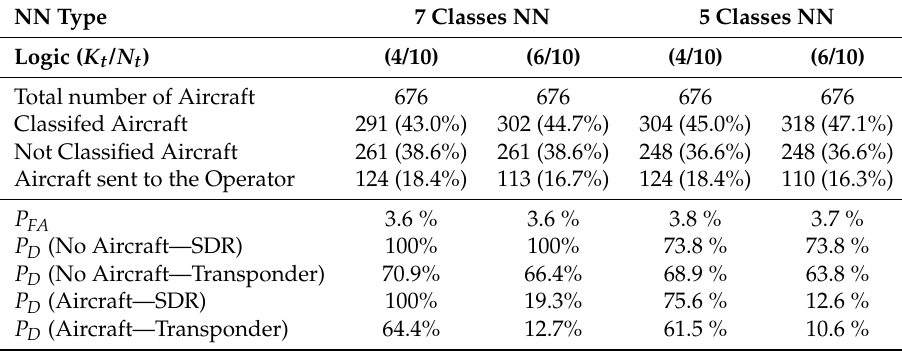
Table 2. Classification statistics, probability of false alarm and probability of detection for different types of attack and different values of ( K t / N t